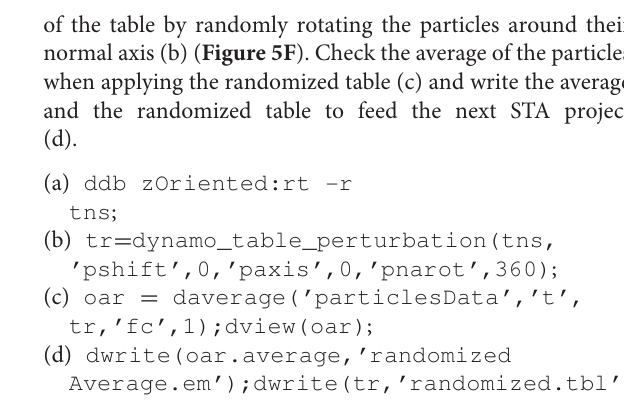
FIGURE 4 | Missing wedge and Fourier compensation. (A) Z view of the Fourier components present when no azimuthal randomization is applied. Bright values mean that the Fourier component is present in many particles, indicating preferential orientations. (B) Z view of the Fourier components present when applying azimuthal randomization by randomization of the table using the function dynamo_table_randomize_azimuth . (C) In dmapview the effect in direct space is shown by depicting both averages, with and without randomization side to side (dmapview({oa.average,oaRandomized.average});) . The effect of the missing wedge is seen as similarly oriented stripes in (C) (left